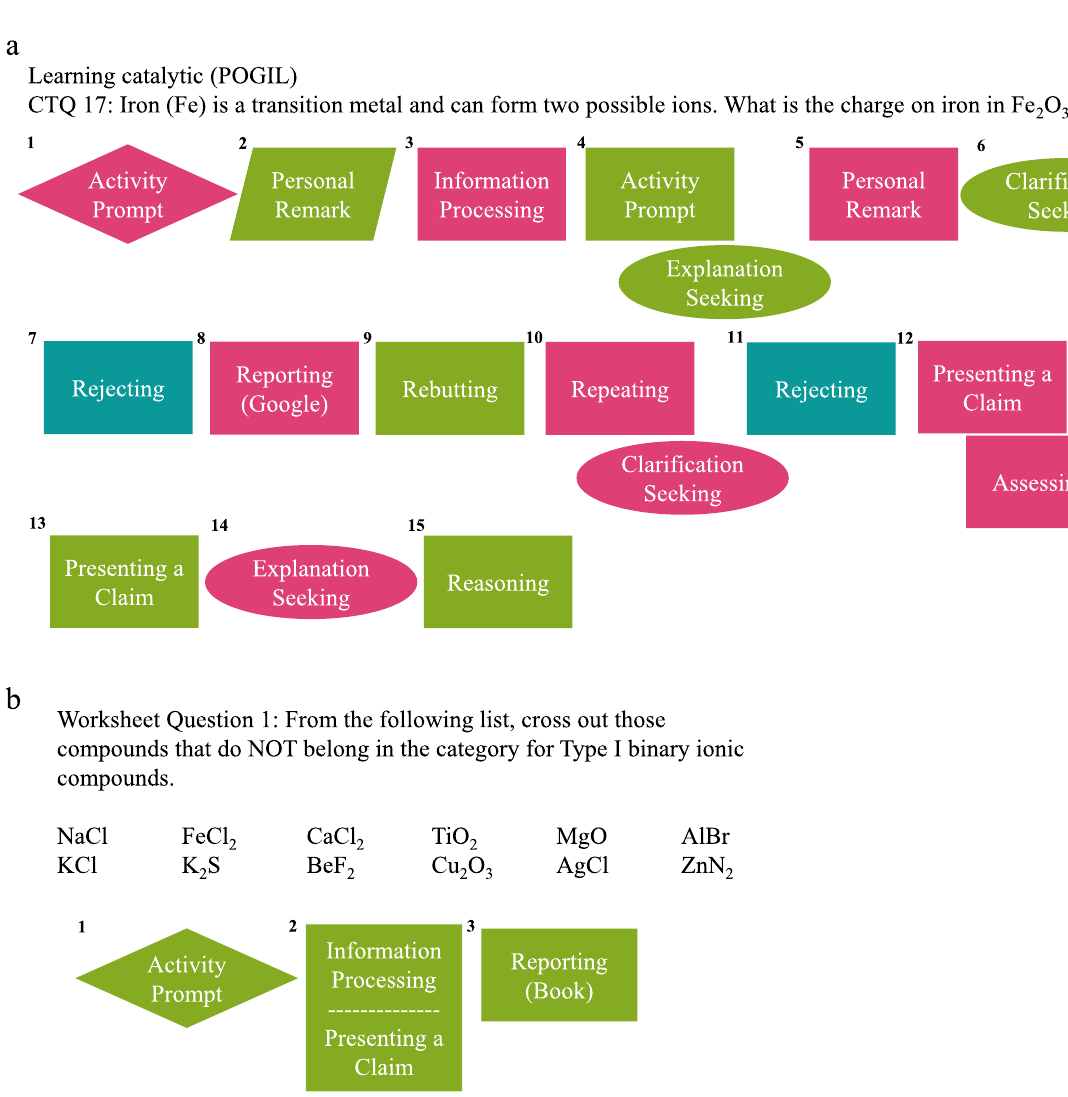
Fig. 3 Discourse map of Tables 4 and 5 excerpts. Panel a is from Table 4 and Panel b is from Table 5. Numbers at the top left corner of each shape correspond to specific lines from the excerpt. Color identifications of students: ,